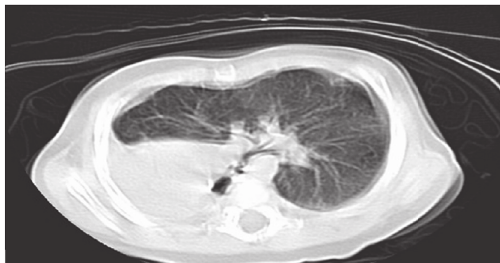
Figure 2: CT chest revealed right lung agenesis, dextrocardia, compression of the distal trachea, and proximal left bronchus beneath the aorta.